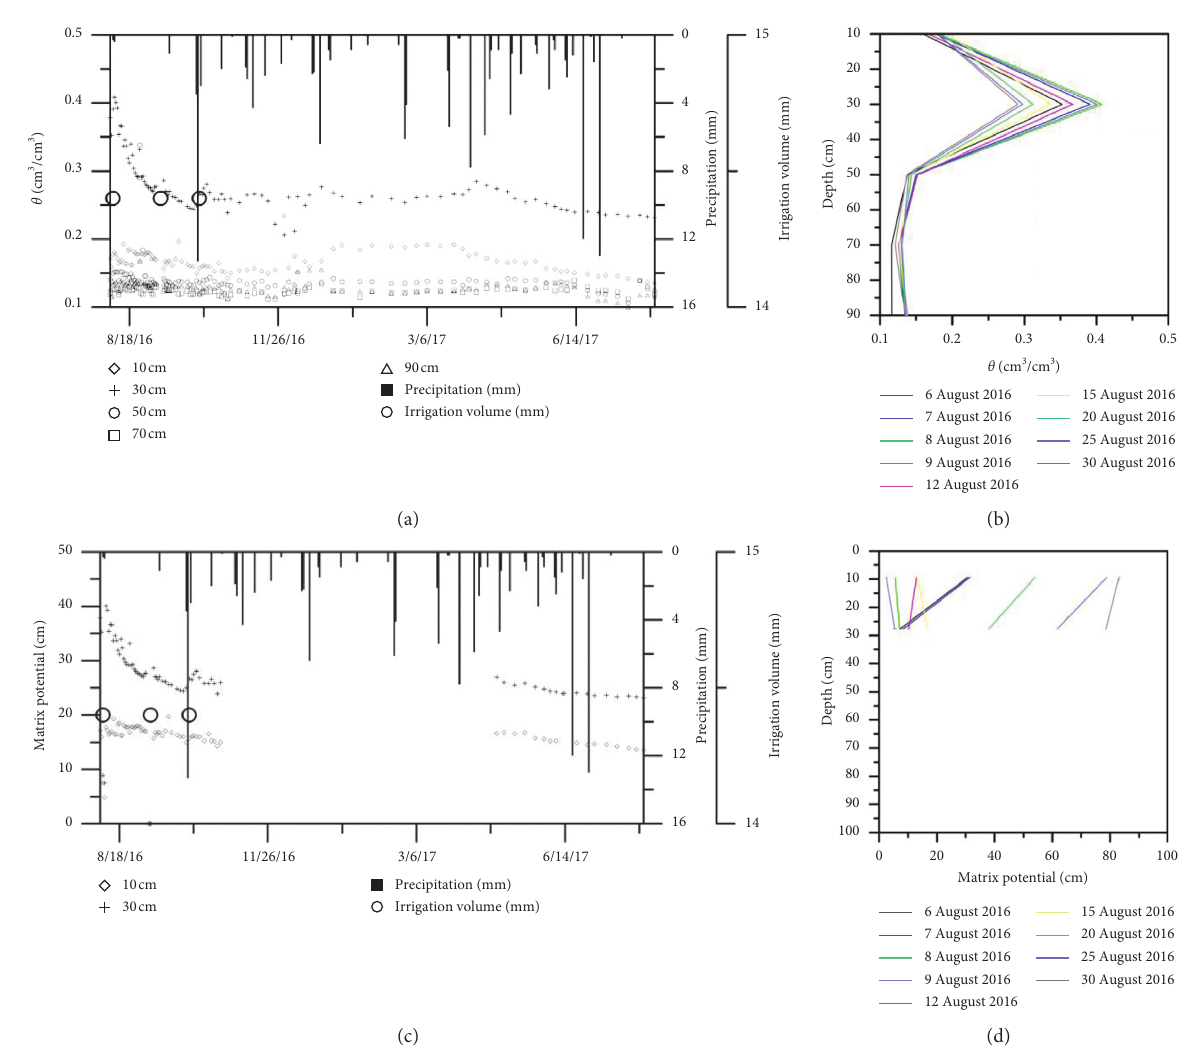
Figure 5: Water distribution in soil with a thickness of 30cm with uncompaction: (a) water distribution at different depths; (b) response of water content to irrigation; (c) matrix potential at different depths; (d) response of matrix potential to